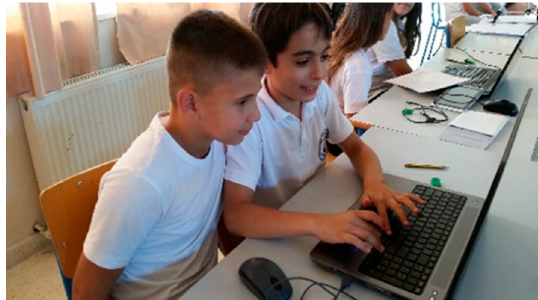
Figure 1. A group in the low-embodied condition.